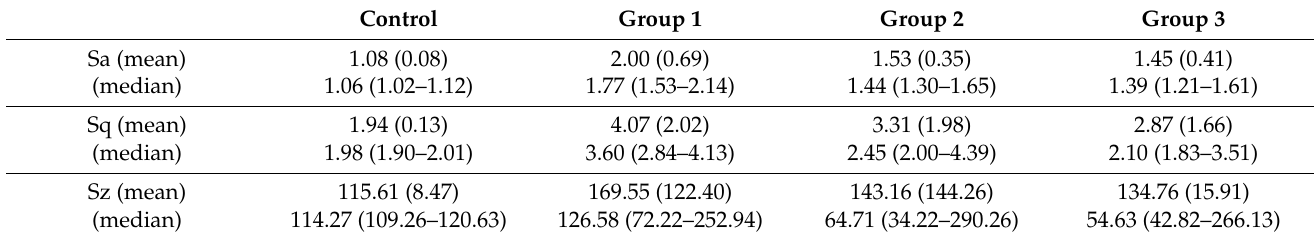
Table 4. Mean and median values of the three variables in µm.